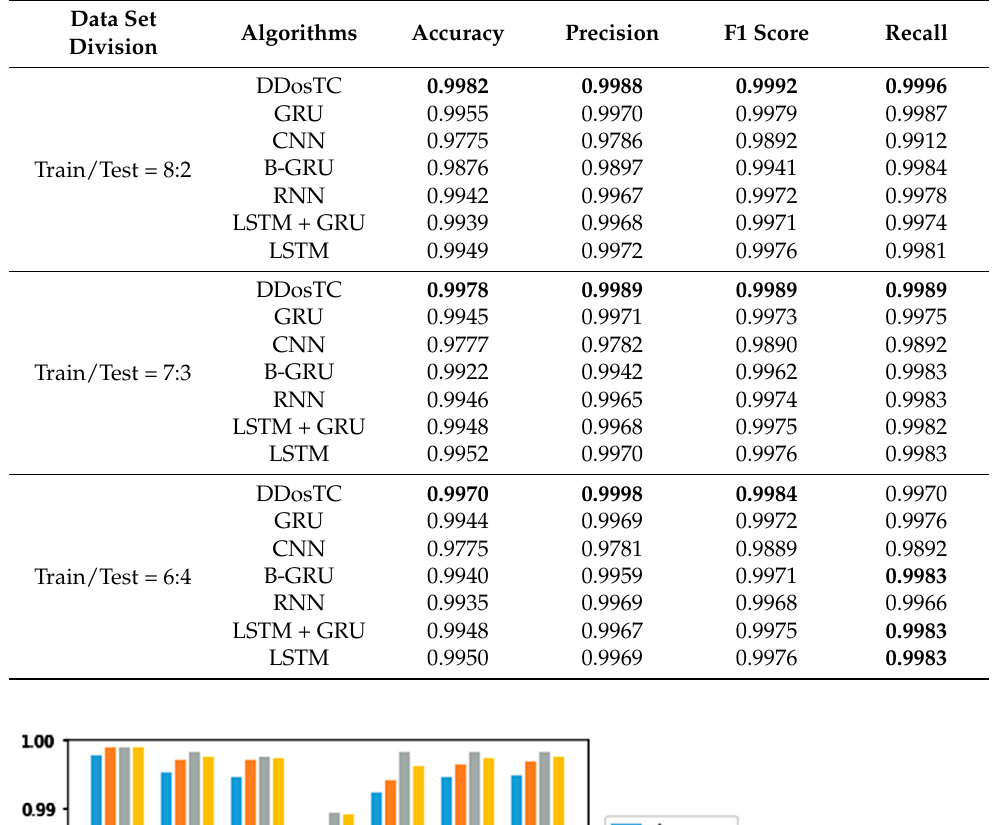
Table 2. A detailed comparison of DDosTC and other models. The bold numbers are our work.